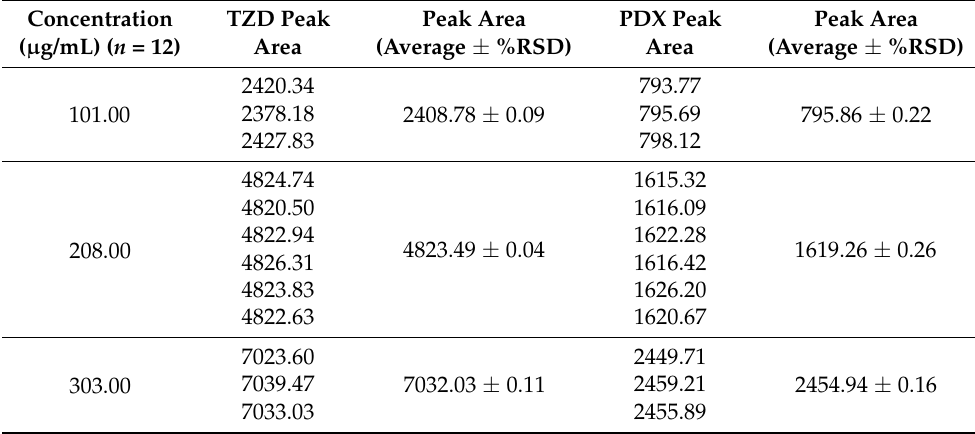
Table 2. Results obtained during repeatability testing of the analytical method.